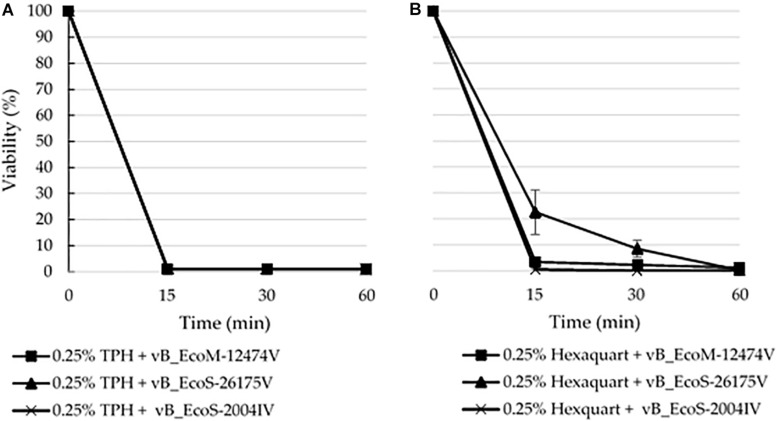
Disinfectant stability of the phages vB_EcoM-12474V (MK907239), vB_EcoS-26175V (MK907271) and vB_EcoS-2004IV (MK907241) in the presence of 0.25% (A) TPH Protect and (B) Hexaquart® plus.